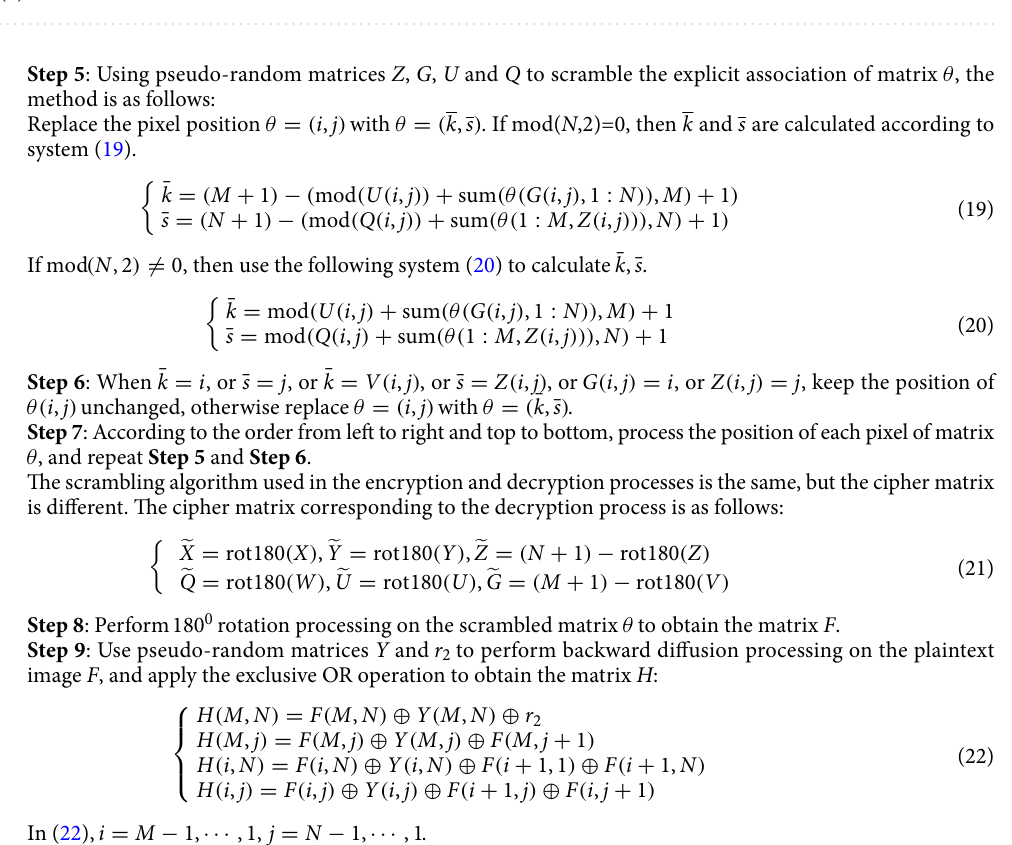
Figure 12. Image encryption system with the same encryption process and decryption process based on system